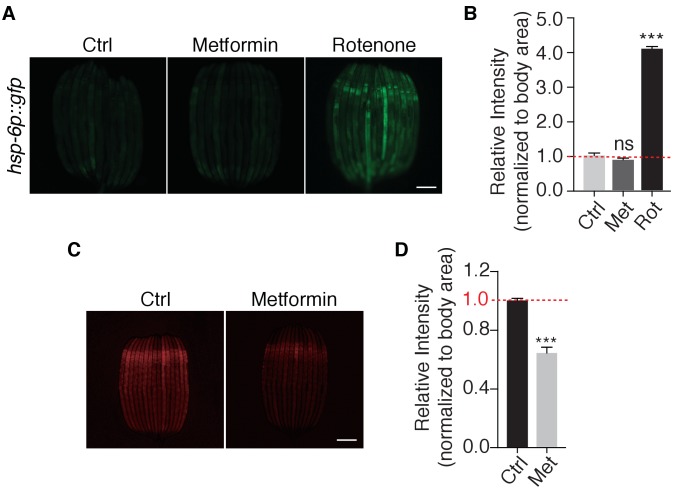
Metformin targets lysosome in C.elegans.(A) Representative fluorescent images of mitochondrial stress response reporter strain hsp-6p::gfp cultured under normal condition, or in the presence of metformin or rotenone. (B) Quantification of fluorescent images in (A). Mean ± SEM of 3 independent biological replicates are shown (sample size:≥40 worms). (C) Representative fluorescent images of Magic Red Cathepsin assay in worms administrated with or without metformin. (D) Quantification of fluorescent images in (C). Mean ± SEM of 3 independent biological replicates are shown (sample size:≥40 worms). Scale bar: 100 um. ns, no significant difference; *p<0.05; **p<0.01; ***p<0.001.